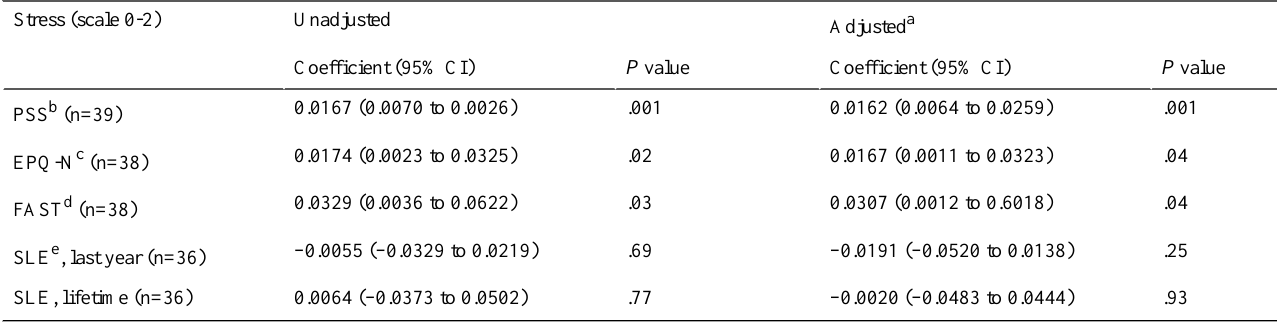
Table 3. Correlations between smartphone-based self-assessed stress and the Perceived Stress Scale, the Eysenck Personality Questionnaire-Neuroticism, the Functioning Assessment Short Test, and the Kendler Stressful Life Events questionnaire (N=39).